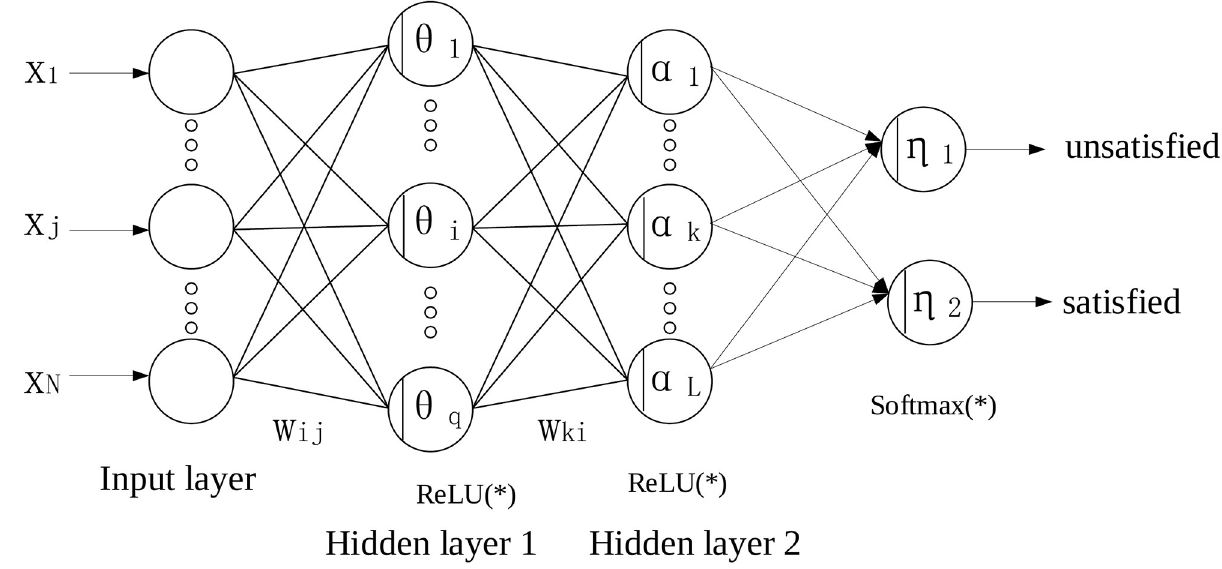
Fig 1. The network architecture of the classification model used in our setting.